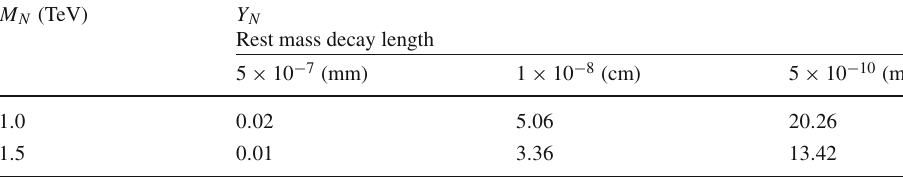
Table 3 Rest mass decay length of N 0 for the chosen